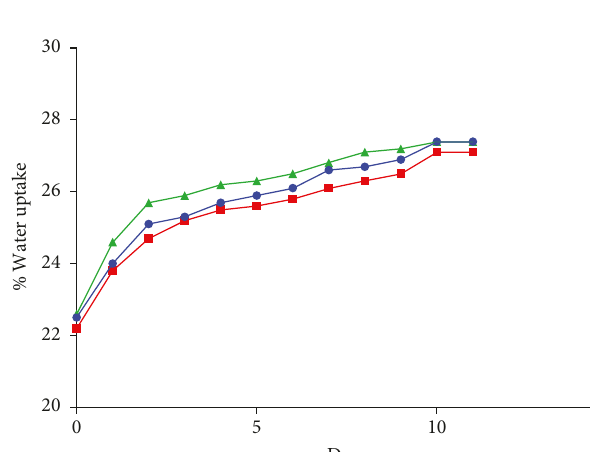
Figure 8: TGA curve of the plastic